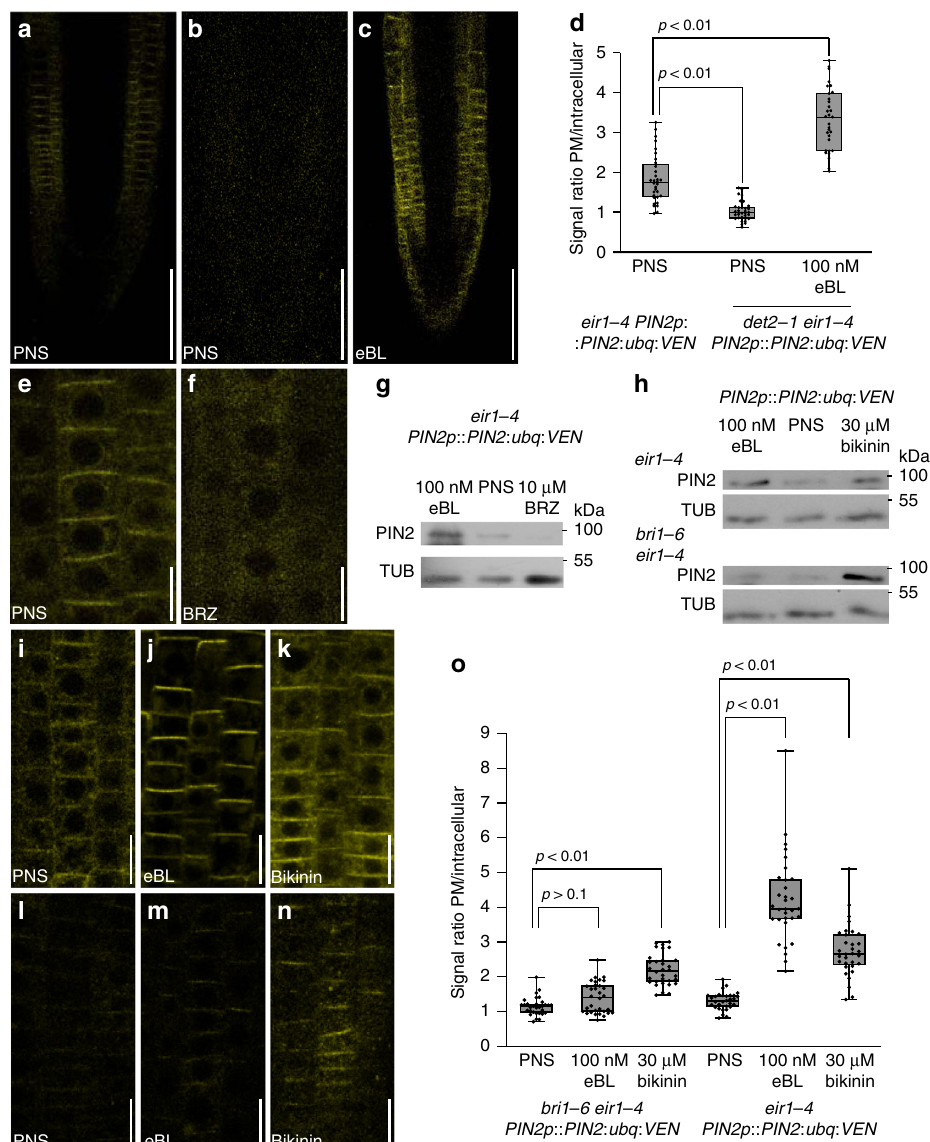
Fig. 2 PIN2:ubq:VEN is controlled by brassinolide homeostasis and canonical eBL signaling. a – c PIN2:ubq:VEN in root tips of eir1-4 PIN2p::PIN2:ubq:VEN ( a ) and det2-1 eir1-4 PIN2p::PIN2:ubq:VEN grown in the absence ( b ) or presence of 100 nM eBL at 6 DAG ( c ). d PIN2:ubq:VEN signal ratios between PM and intracellular space in eir1-4 PIN2p::PIN2:ubq:VEN and det2-1 eir1-4 PIN2p::PIN2:ubq:VEN . 31-32 root epidermis cells in fi ve roots were tested for each dataset. Relevant p -values obtained by One-way ANOVA with post-hoc Tukey HSD test are indicated. e, f PIN2:ubq:VEN distribution and abundance in 6 DAG eir1- 4 PIN2p::PIN2:ubq:VEN root epidermis cells incubated on PNS ( e ) or after 16 h incubation on 10 μ M Brassinazole (BRZ; f ). g Western blots of eir1-4 PIN2p:: PIN2:ubq:VEN membrane protein fraction, probed with anti-PIN2. Samples were incubated for 16 h in the presence of 100 nM 24-epiBL, 10 μ M BRZ, or solvents only (PNS). h Western blots of eir1-4 PIN2p::PIN2:ubq:VEN (top panel) and bri1-6 eir1-4 PIN2p::PIN2:ubq:VEN (bottom panel) membrane protein fraction, probed with anti-PIN2. Samples were incubated for 16 h in the presence of 100 nM 24-epiBL, 30 μ M bikinin, or on solvents only (PNS). i – n PIN2: ubq:VEN in root tips of eir1-4 PIN2p::PIN2:ubq:VEN ( i – k ) and bri1-6 eir1-4 PIN2p::PIN2:ubq:VEN ( l – n ) on PNS ( i , l ), or after incubation on 100 nM eBL ( j , m ) or 30 μ M bikinin ( k, n ) for 16 h. o PIN2:ubq:VEN signal ratios between PM and intracellular space in eir1-4 PIN2p::PIN2:ubq:VEN and bri1-6 eir1-4 PIN2p::PIN2: ubq:VEN . 31-32 root meristem epidermis cells in 6 roots were tested for each dataset. Relevant p-values obtained by One-way ANOVA with post-hoc Tukey HSD test are indicated. Anti- α -tubulin (TUB) was used as loading control for Western blots. Whiskers in box plots cover the entire range of outliers obtained in the datasets; gray boxes: fi rst and third quartiles; center line: median; dots: values obtained. Scale bars: a – c = 50 μ m; e,f,i – n = 10 μ m. Source data are provided as Source Data fi le.